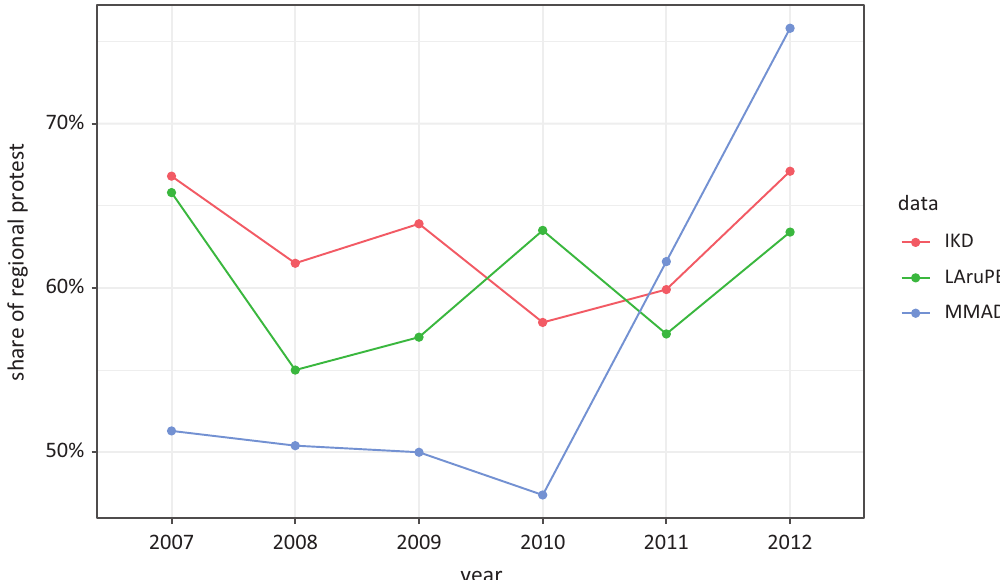
Figure 2. Share of protest events outside Moscow and St. Petersburg over time, by data source (March 2007–March